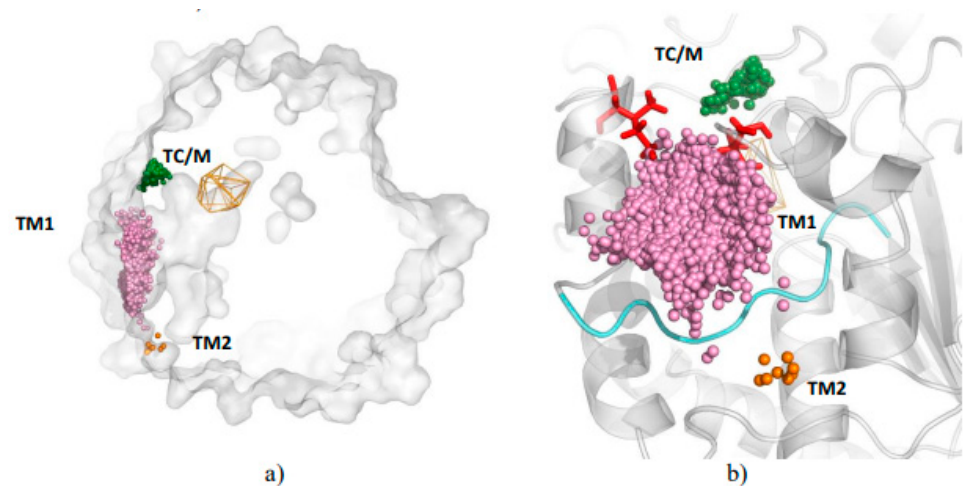
Figure 1. Localisation of areas of water molecule entry/egress (clusters) to active site of Solanum tuberosum epoxide hydrolase (StEH1): ( a ) cross-section of the protein showing network of internal cavities with large funnel providing wide access to active site (orange wire-frame); ( b ) close-up of structural features dividing the main water clusters: (i) loop (cyan) and (ii) I148 and I270 residues (red sticks). Small balls represent single inlets of water molecule entry/egress, colours correspond to identified clusters (green—TC/M, pink—TM1, orange—TM2). Biomolecules 2018 , 8 , x FOR PEER REVIEW